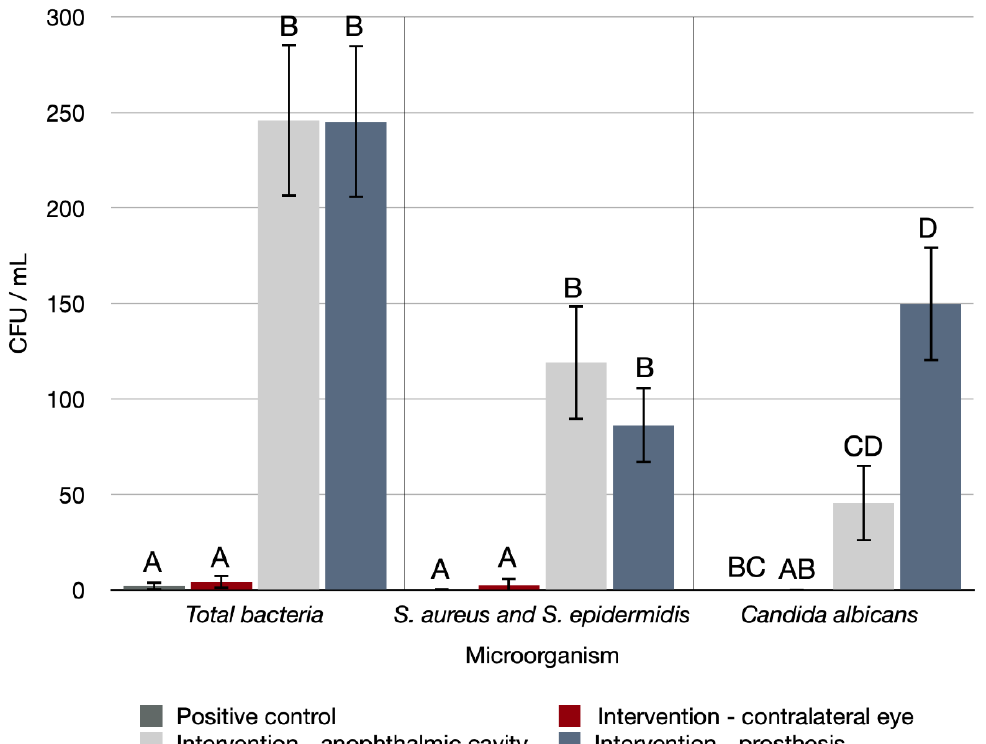
Figure 1. Number of CFUs/mL of the different types of microorganisms evaluated in the initial period in the different regions analyzed in the IG compared with the CG. Capital letters indicate a statistically significant difference for each type of microorganism separately (Kruskal–Wallis, p < 0.05).